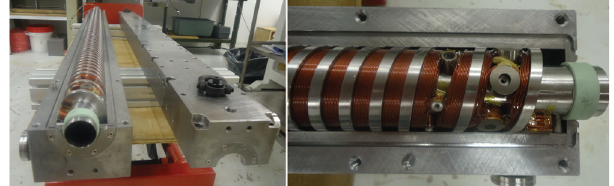
FIG. 11. HSCU magnet test fit into the mold before epoxy impregnation.